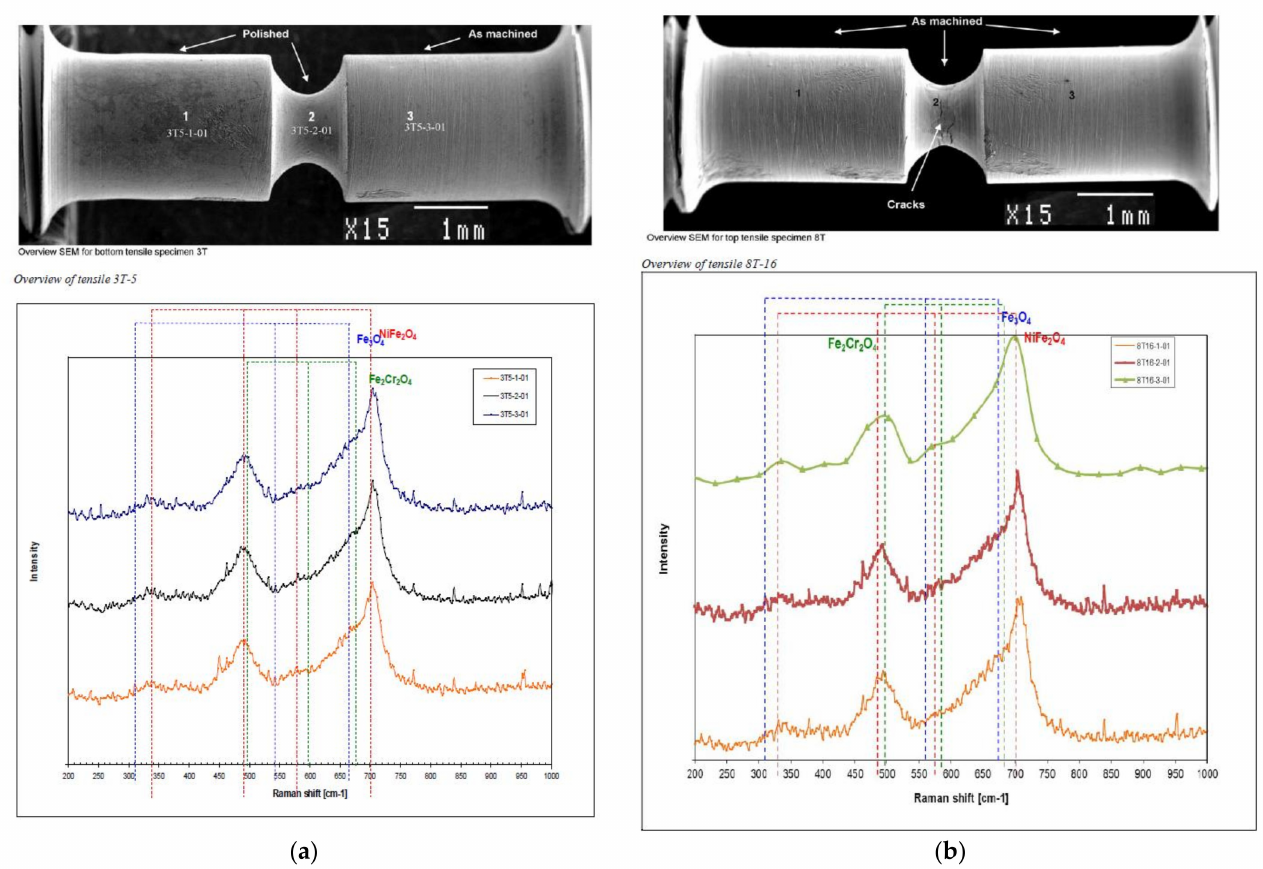
Figure 15. ( a ) Raman spectra of IFA-727.2, tensile sample 3T-5 (316L SS with polished regions), after 22 full power day irradiation in the HBWR; ( b ) Raman spectra of IFA-727.2, tensile sample 8T-14 (as-machined 316LN SS), after 107 full power day irradiation in the HBWR. As a result, the 316L SS plate samples exhibited slight weight gain (in the range +0.00005 to ~+0.00015 mg) while the 316LN SS samples showed slight weight loss